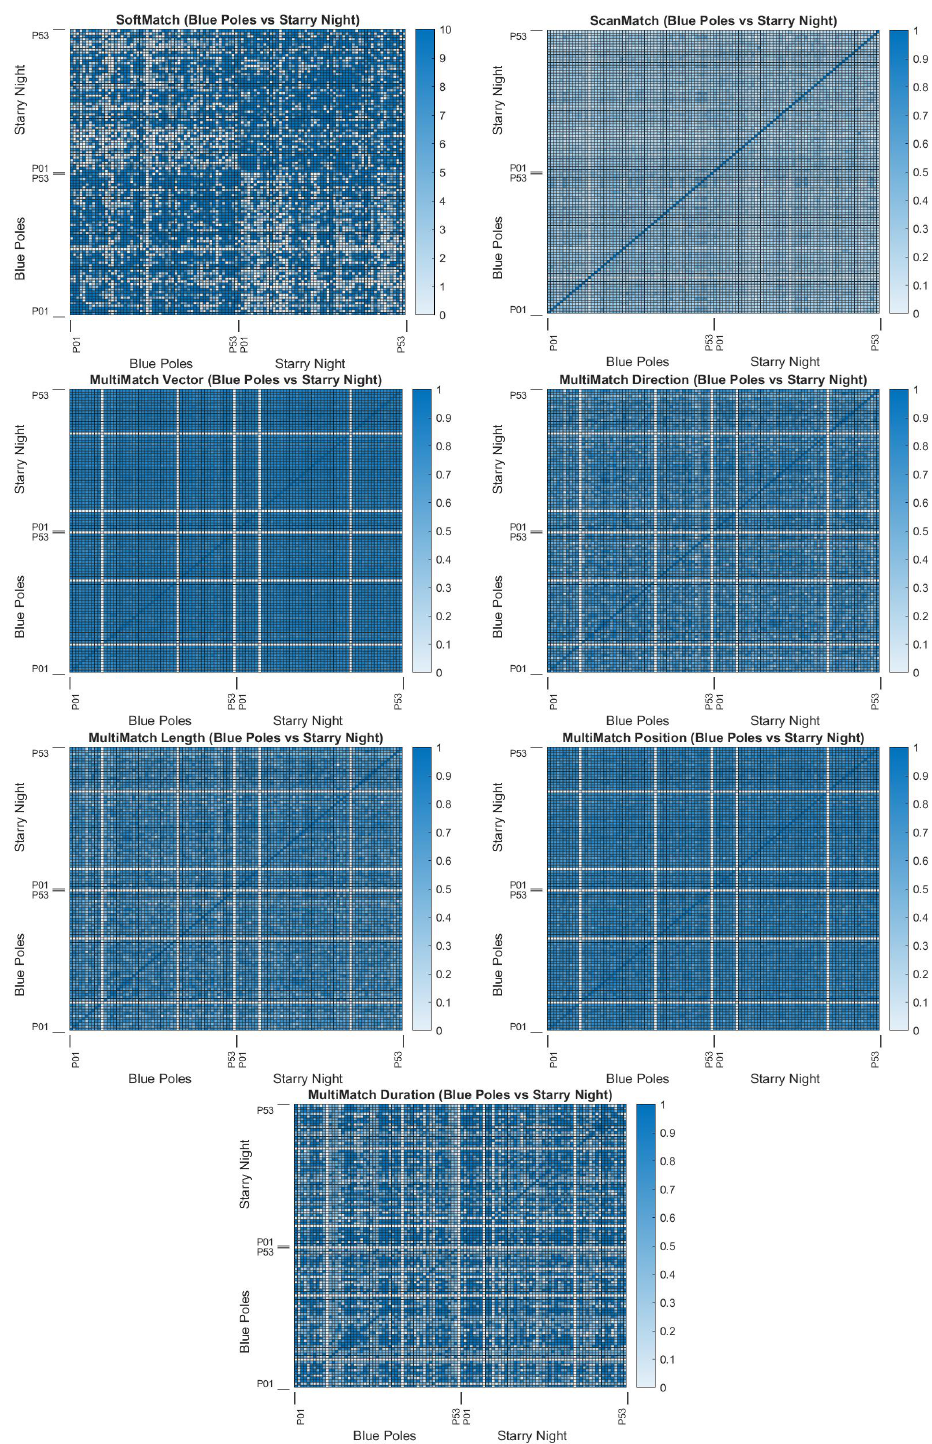
Figure A4. SoftMatch, ScanMatch, and MultiMatch heatmaps for empirical evaluation. Stimuli matched are Jackson Pollock’s Blue Poles (1952) and Vincent van Gogh’s Starry Night